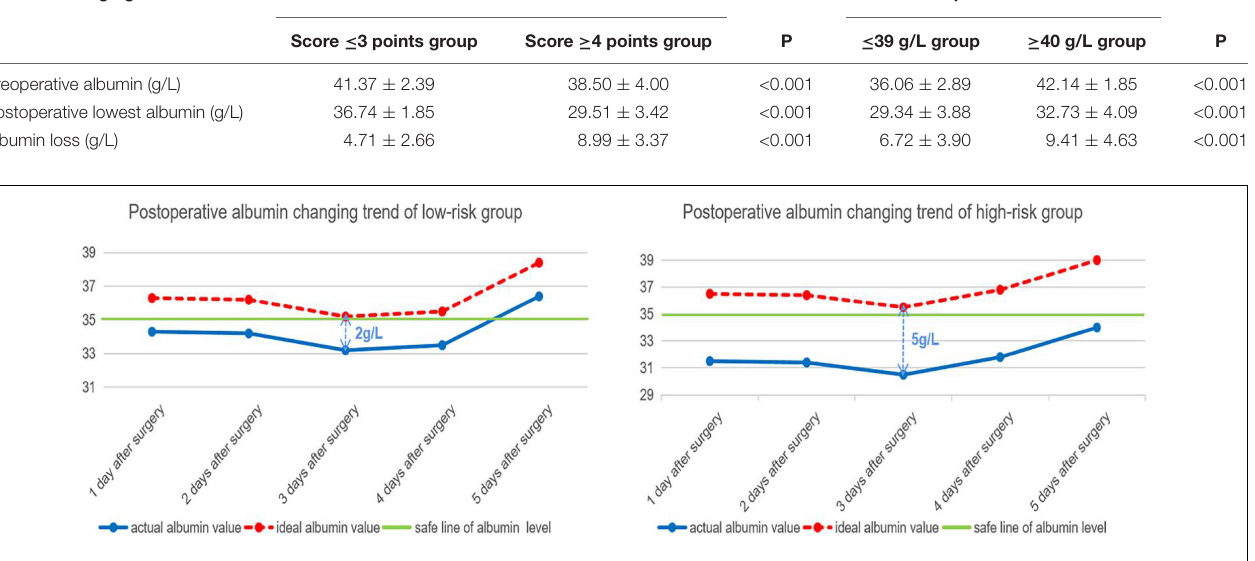
FIGURE 4 | Postoperative albumin changing trend of low-risk group and high-risk group.